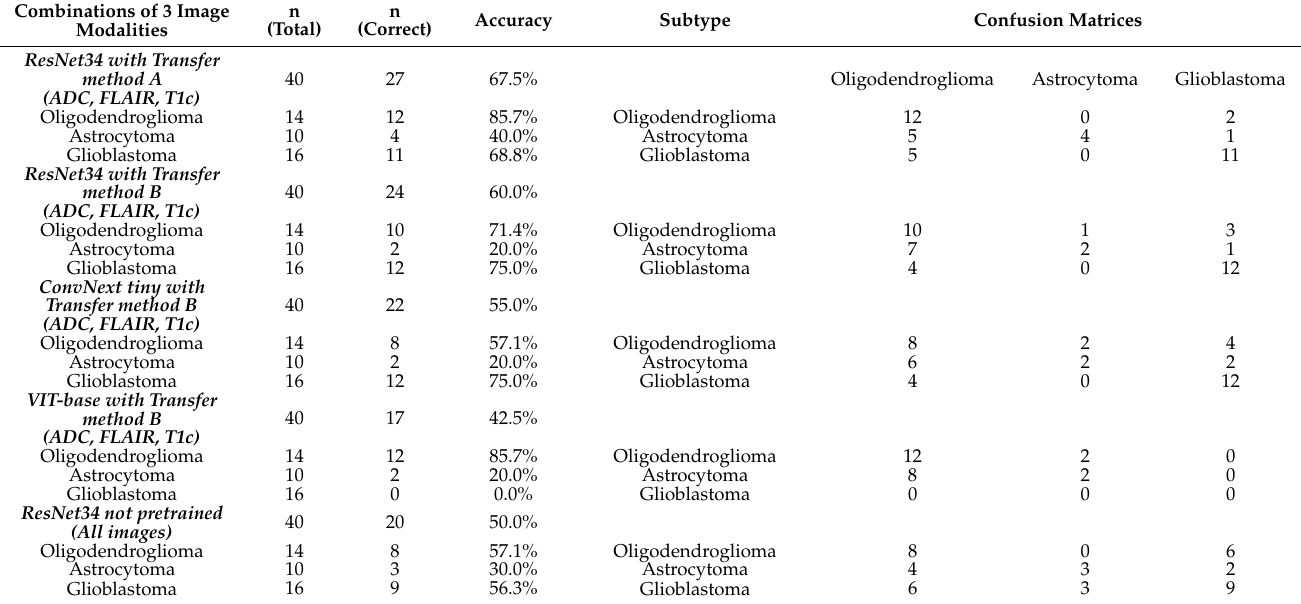
Table 5. Summary of classification results for different strategies of transfer learning on test sets.